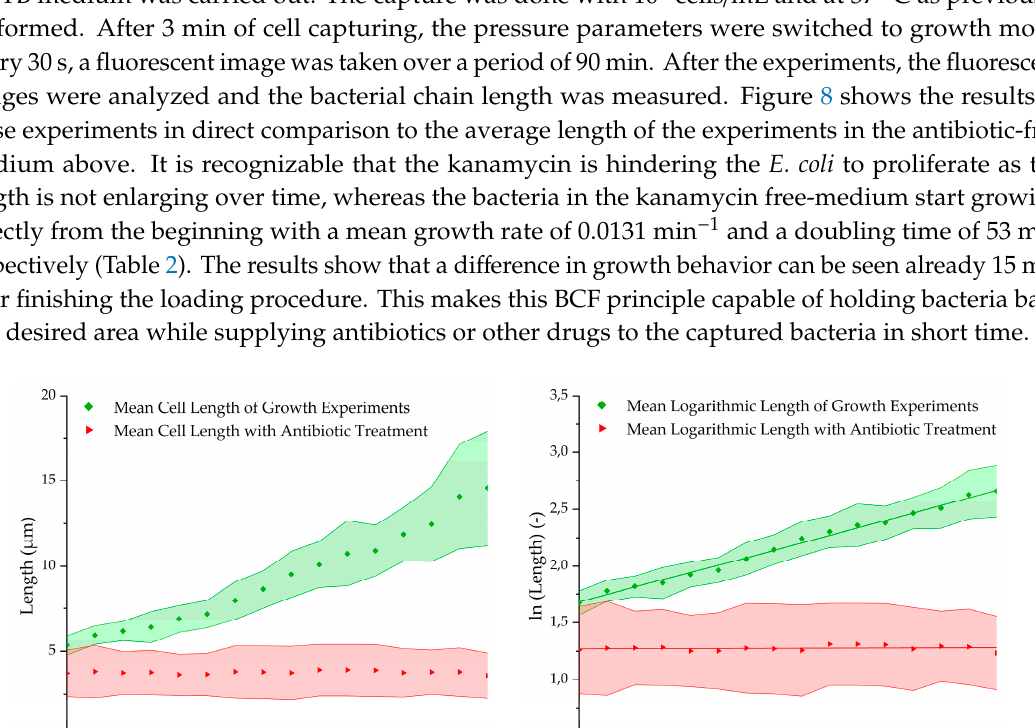
Table 2. Specific growth rate of each immobilized and observed E. coli cell at the nanogap at 37 °C with TB medium flowing around the bacteria.